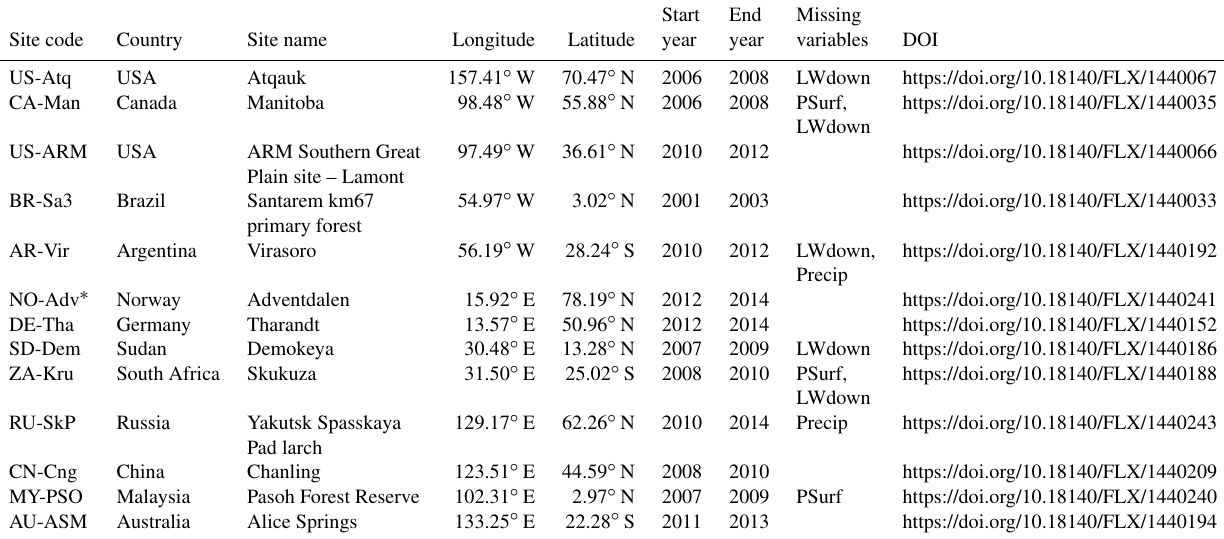
Table 4. Selected FLUXNET2015